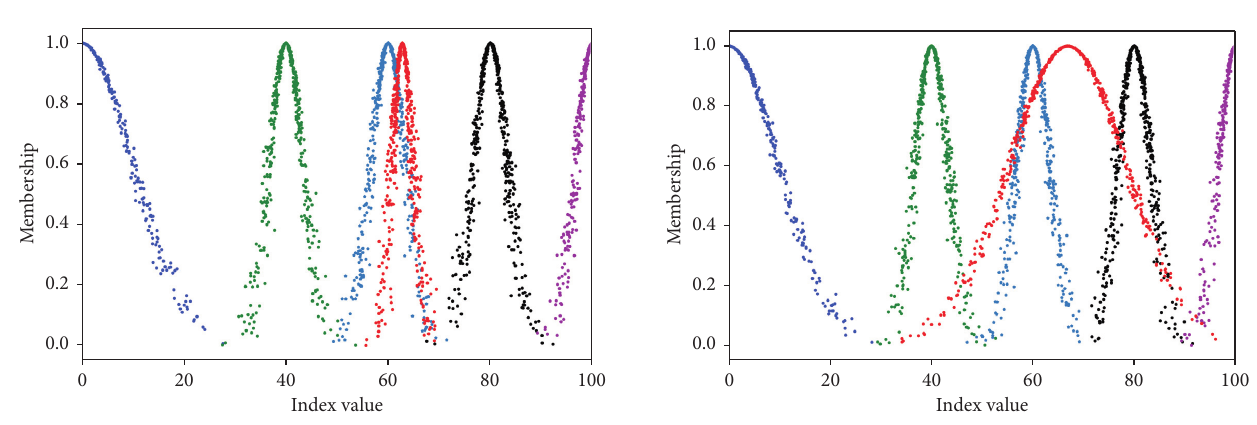
Figure 8: Cloud map of operational risk.